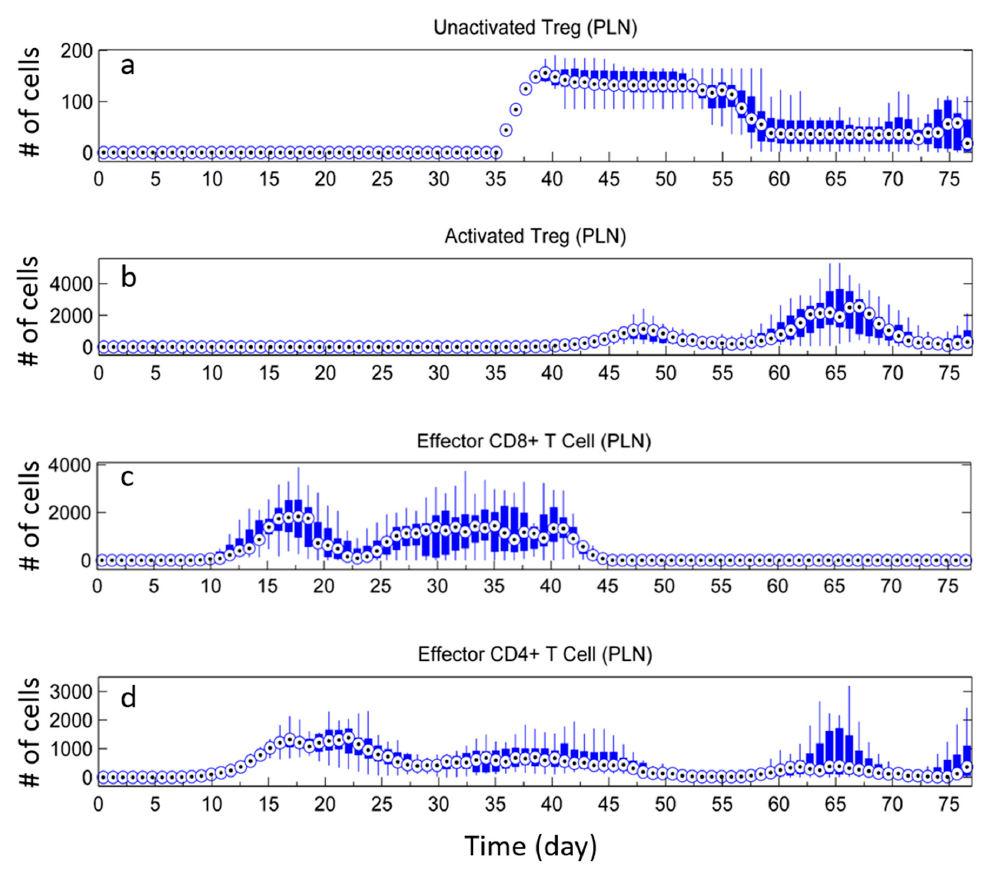
Figure 9. Simulation results for case with Tregs intervention (case VI). Tregs were added at 8th week. The number of ( a ) unactivated Tregs, ( b ) activated Tregs, ( c ) effector CD8 + T cells, ( d ) effector CD4 + T cells in PLN are shown. t = 0 days correspond to 3-week age of mouse.